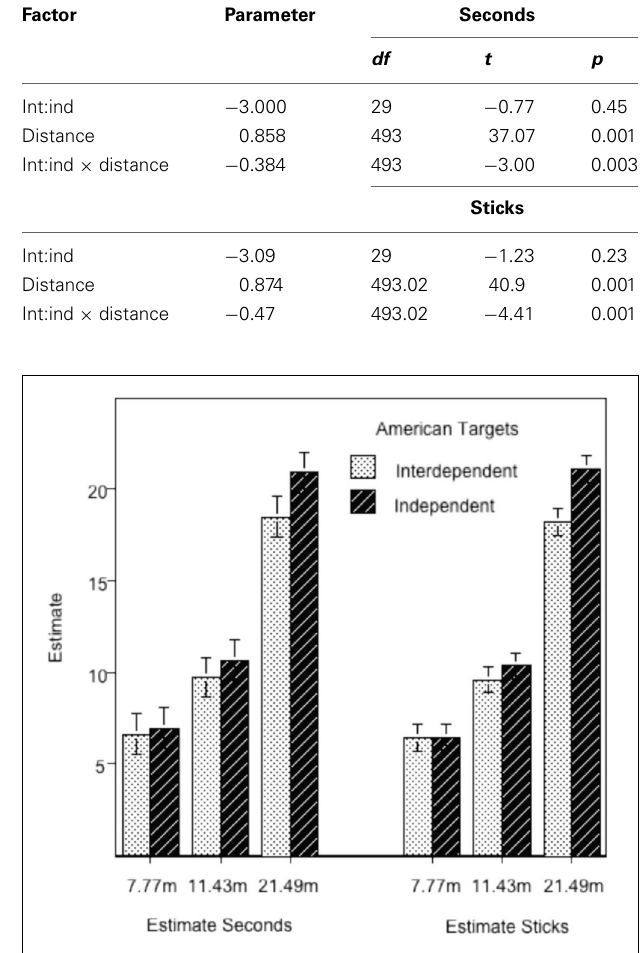
FIGURE 1 | Regression-estimated mean distance judgments to American-looking targets. Actual distance is indicated on the abscissa. Left: data from Americans estimating distance as time to walk to the target; Right: distance estimated as number of hand-held sticks to the target.